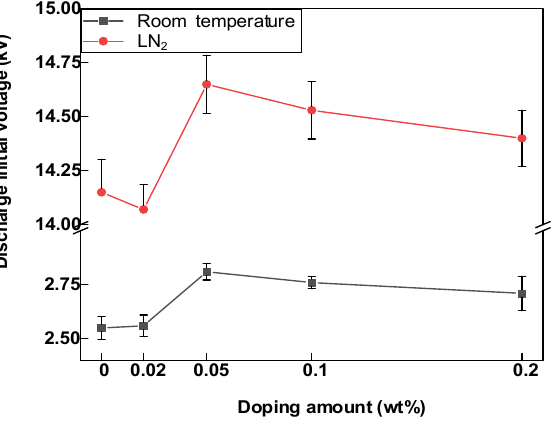
Figure 5. DC surface discharge initial voltage of epoxy resin–GO